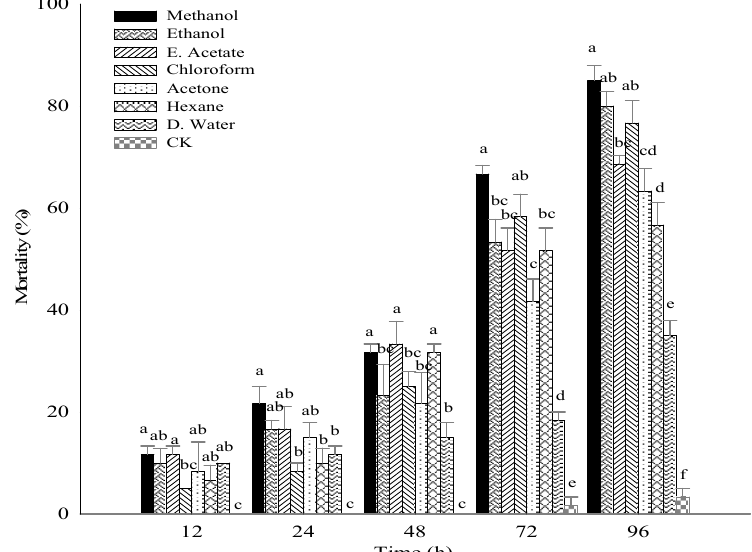
Figure 1. Mortality of Brevicoryne brassicae by Citrullus colocynthis leaves extracts. Values are represented as mean ± standard deviation followed by different superscripts (a, b, c, d, e, f, ab, bc, cd) were not significantly different according to Duncan multiple range test (DMRT) at p > 0.05. E. Acetate (ethyl